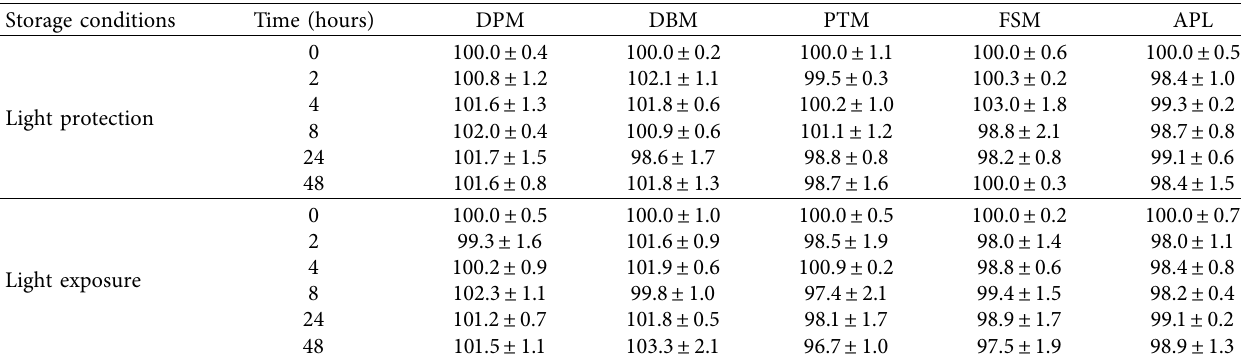
Table 7: Mean concentrations of DPM, DBM, PTM, FSM, and APL in 5% glucose injection with light protection or light exposure at 25 ° C. Storage